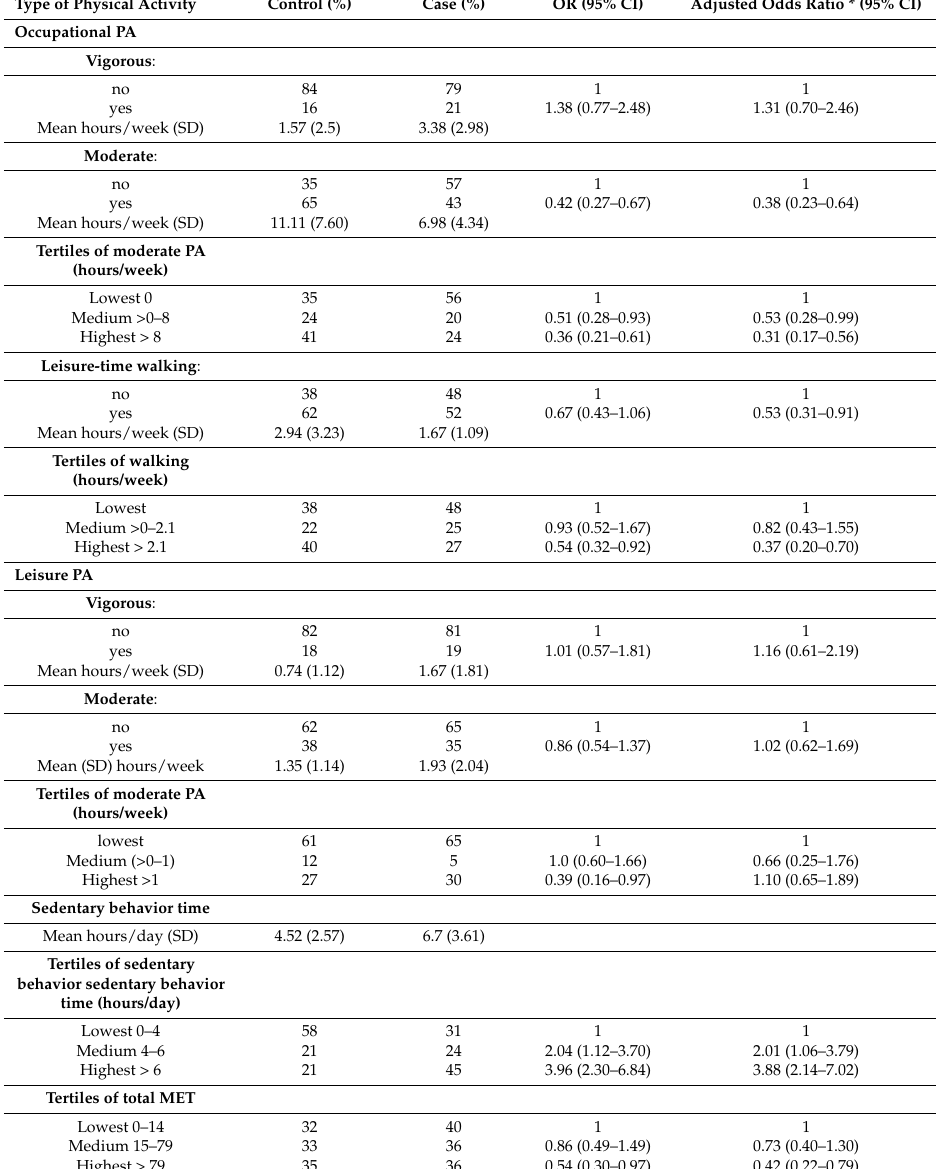
Table 2. Coronary heart disease risk according to different types and levels of physical